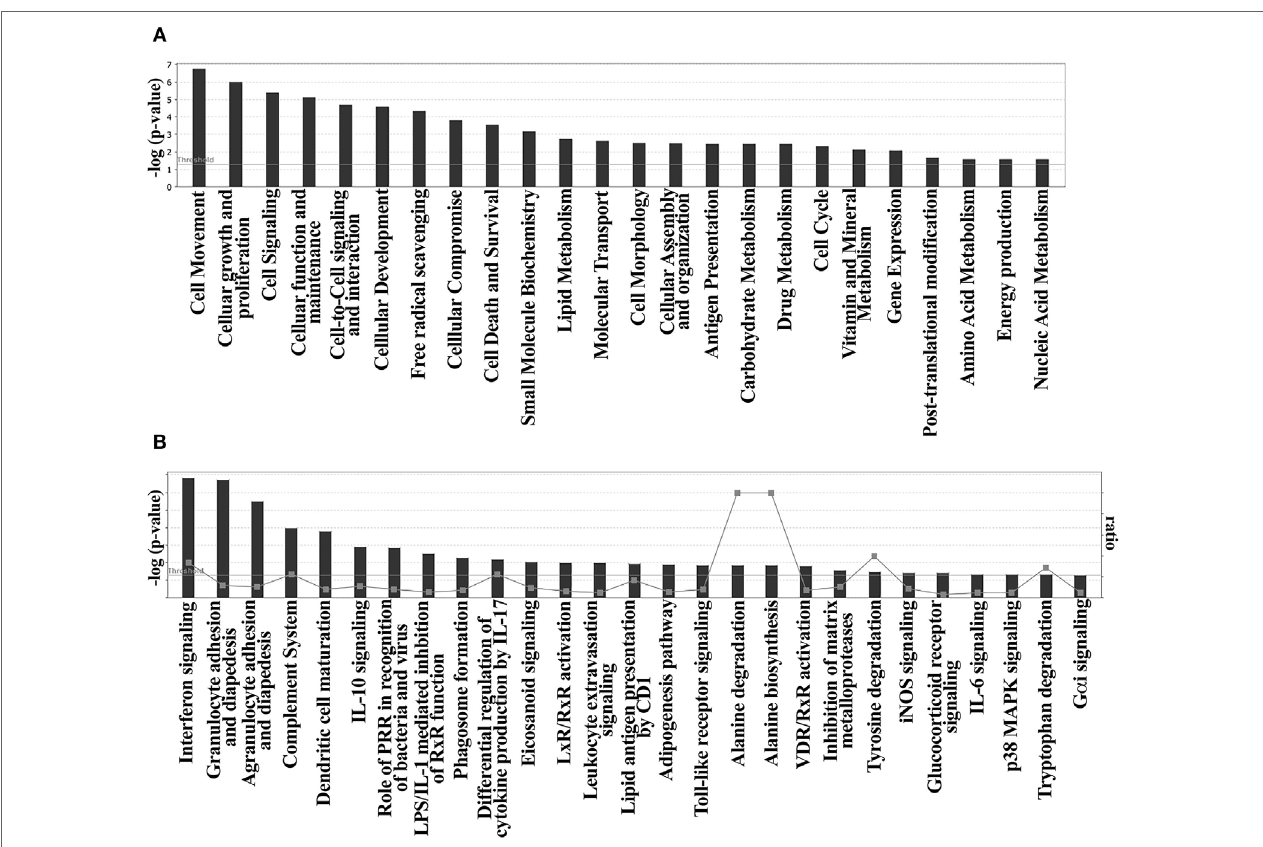
FigUre 2 | Functional enrichment analysis reveals modulation of cell migration, signaling and metabolism on dexamethasone (Dex)-modulated and monophosphoryl lipid A (MPLA)-activated dendritic cells (DM-DCs). Ingenuity pathway analysis (IPA) functional GO overrepresentation of biological functions of 259 differentially expressed genes found on monocyte-derived DCs shows an enrichment of genes related to cell movement, cellular proliferation, signaling, and metabolism. Consistent with functional analysis, Dex and MPLA were found to modulate genes involved in the canonical pathways of cell signaling, cell adhesion and diapedesis, complement system, DC maturation and metabolism. (a) Biological functions enriched on DM-DCs. (B) Canonical pathways overrepresented on